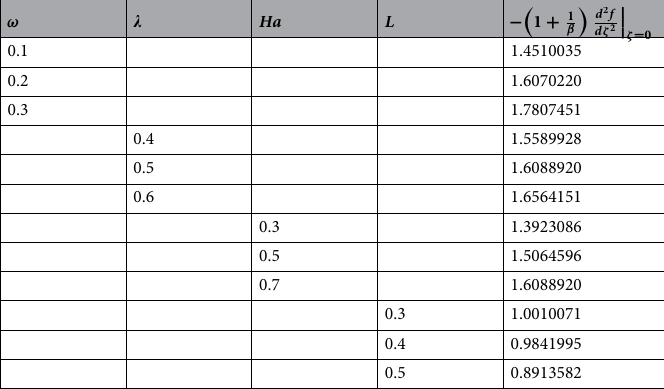
Table 2. Computationalvalues of friction drag coefficient for distinct values of ω , (cid:31) , Ha and L .